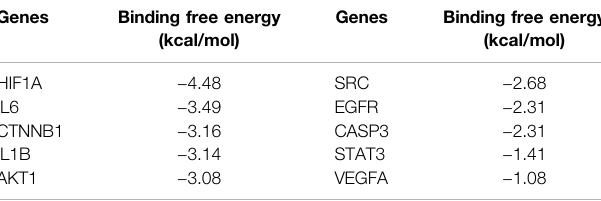
TABLE 2 | The binding free energy of AS- Ⅳ docking with core target molecules. Genes Binding free energy Genes Binding free energy (kcal/mol)